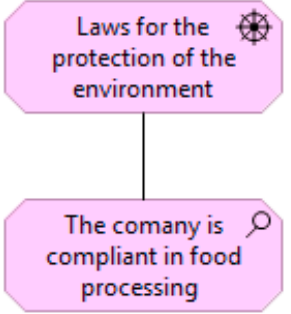
Figure 4. Analysis of external factors and political environment.